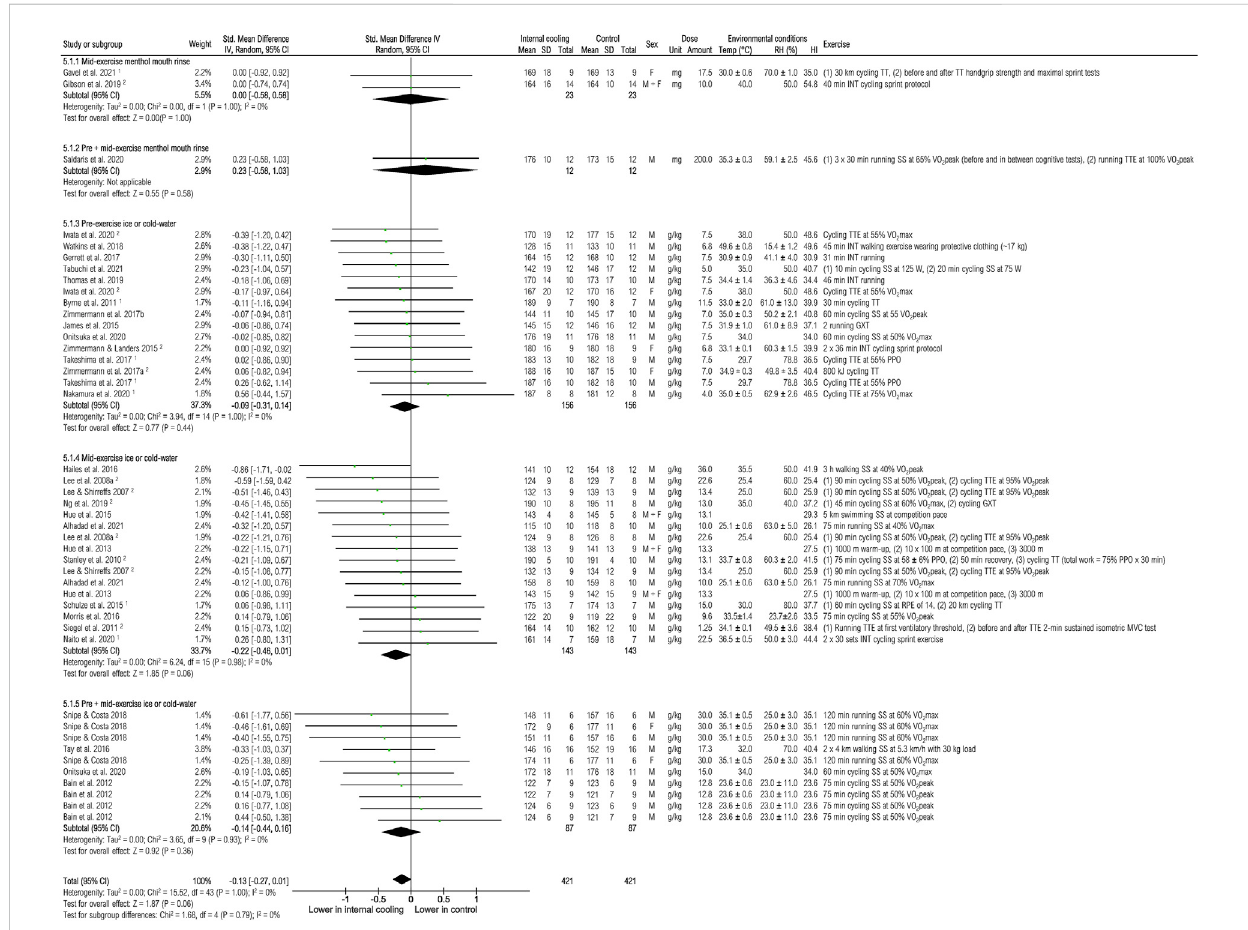
FIGURE 8 Meta-analysis of standardized mean difference in heart rate [bpm] with 95% CI between internal cooling and control. 1 Studies with signi fi cant positive performance effects of internal cooling. 2 Studies with no performance effects of internal cooling. F, female; GXT, graded exercise test; HI, heat index; INT, intermittent exercise; M, male; MVC, maximum voluntary contraction; PPO, peak power output; RH, relative humidity; RPE, rate of perceived exertion; SS, steady-state exercise; Temp, ambient temperature; TT, time trial; TTE, time to exhaustion; VO 2 max, maximum oxygen consumption; VO 2 peak = peak oxygen consumption.